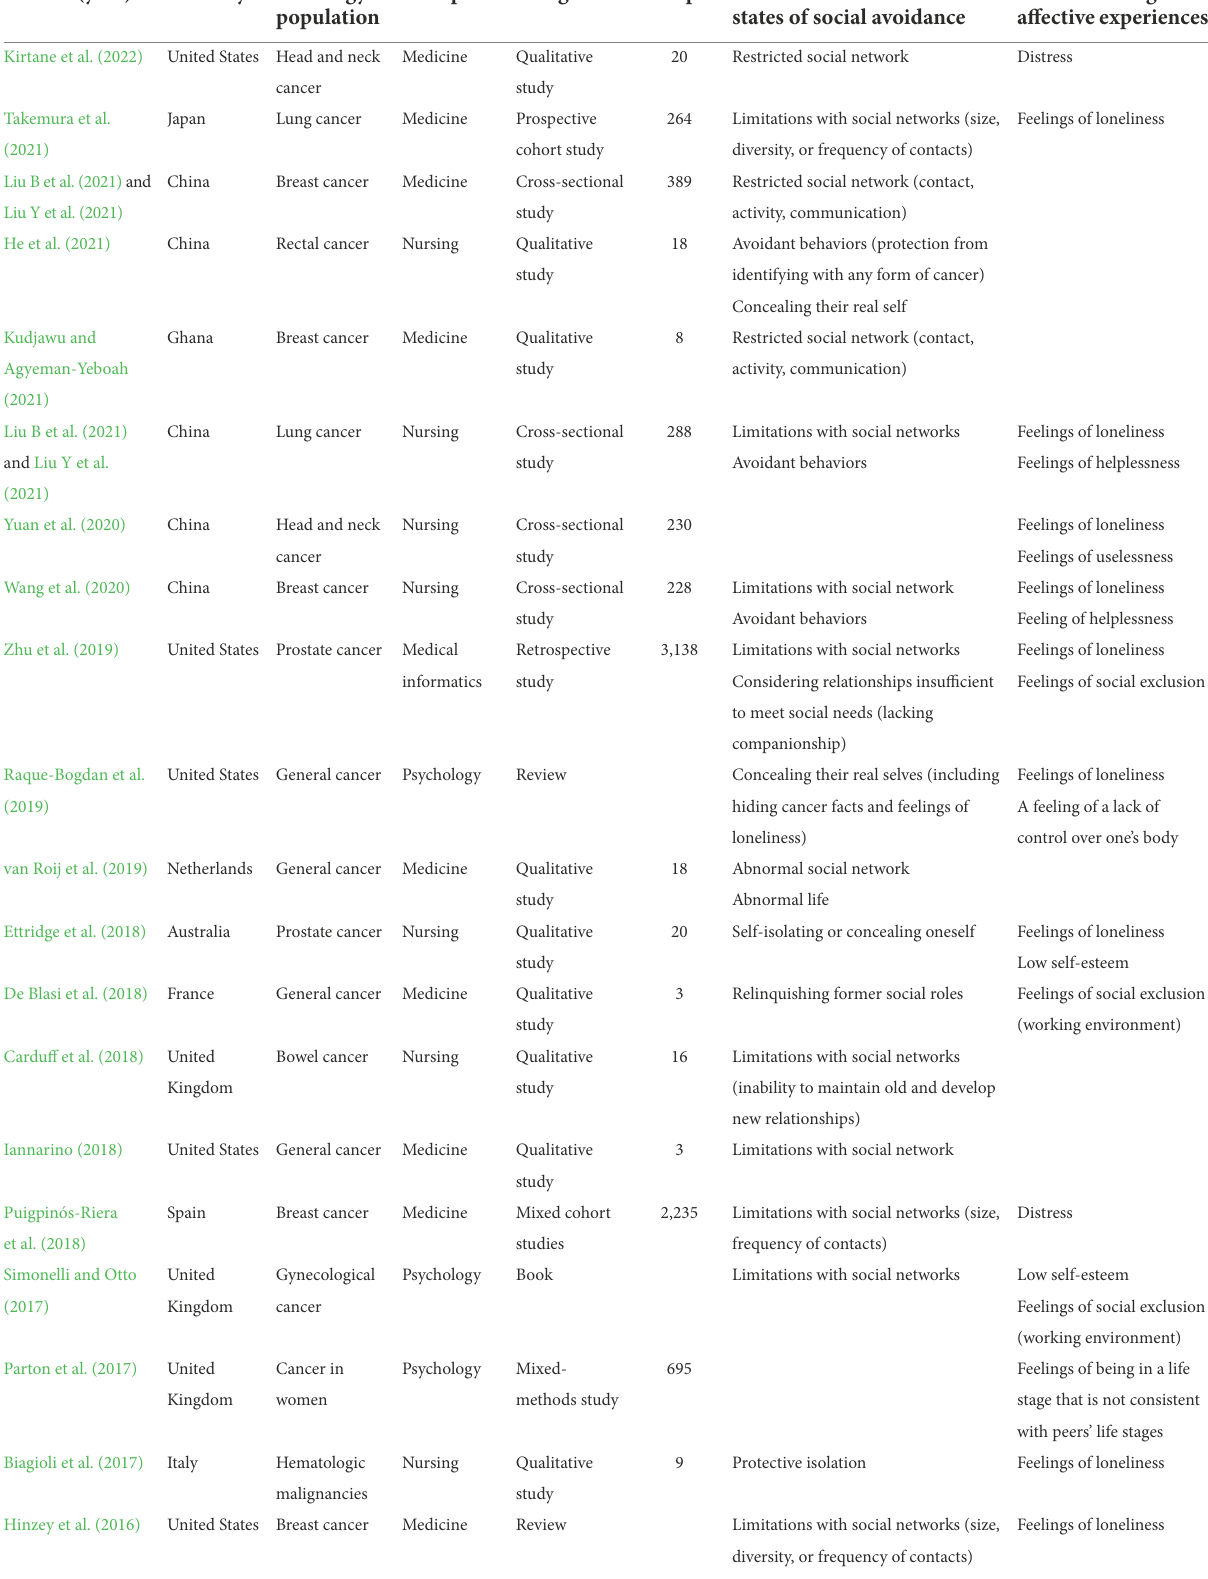
TABLE 3 Overview of the characteristics and attributes of social isolation defined in the studies included in the concept